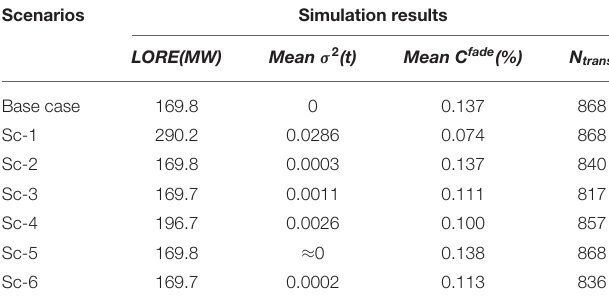
TABLE 2 | Simulation results of modeled